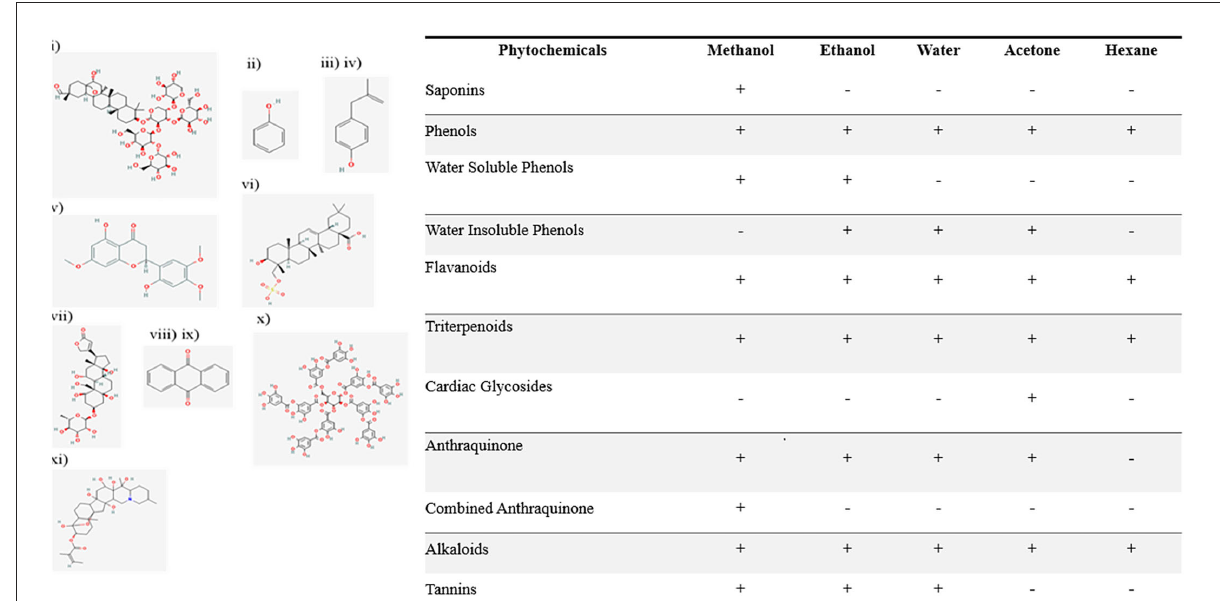
FIGURE1 Qualitative analysis of phytochemicals in polar and non-polar extracts of Nepeta cataria . List of phytochemicals from (i) to (xi) were identified in various polar and non-polar extracts. The 2-D structure of phytochemicals are supported via PubChem.